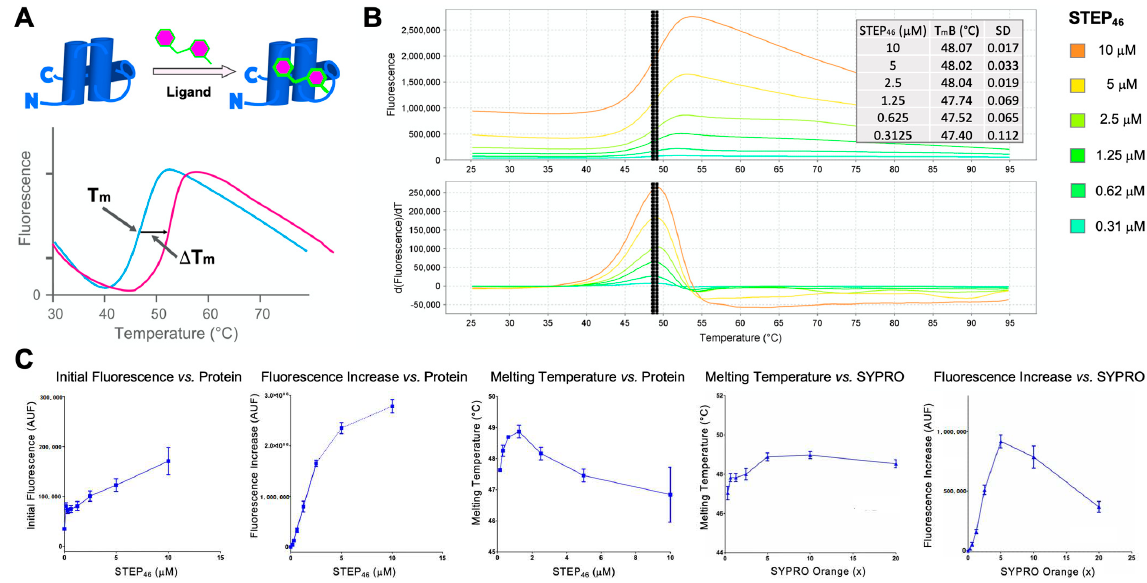
Figure 4. ( A ) Protein thermal shift (PTS) assay principle. Globular protein can be stabilized or destabilized by small-molecule binding, resulting in a change in the protein melting temperature (T m ). ( B ) STEP 46 titration in the PTS assay. Melt curves (top) and first derivative plots (bottom) are shown for various concentrations of STEP 46 . Data were recorded using a ViiA 7 thermocycler and analyzed using Protein Thermal Shift software. The STEP 46 melting profiles demonstrate a single inflection point and a single peak in the first derivative plot, with narrow error margins for the derivative melting temperature. The inset table lists the Boltzmann melting temperature (T m B) and standard deviation (SD) for each STEP 46 concentration tested. ( C ) STEP 46 PTS assay optimization. The initial fluorescence (F i ) and fluorescence signal increase ( ∆ FI) for various STEP 46 concentrations are shown in the two panels on the left. The middle panel shows the measured STEP 46 T m B at various STEP 46 concentrations. The two panels on the right exhibit the STEP 46 T m B as well as ∆ FI at various SYPRO Orange